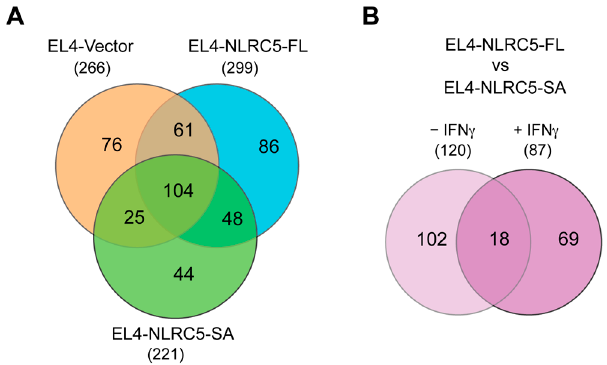
Figure 6. NLRC5-SA significantly differs from NLRC5-FL in modulating steady-state and IFN γ - stimulated MAPs. ( A ) Comparison of 8–13aa MAPs that are not a ff ected by IFN γ stimulation in each of the EL4-derived cell lines. The lists of 8–13aa peptides used in ( A ) are given in Supplemen- tary Table S4. ( B ) The 8–13aa MAPs shared between EL4-NLRC5-FL and EL4-NLRC5-SA cells under steady state or IFN γ -stimulated conditions but absent from EL4-vector cells. The lists of peptides are given in Supplementary Table S5.